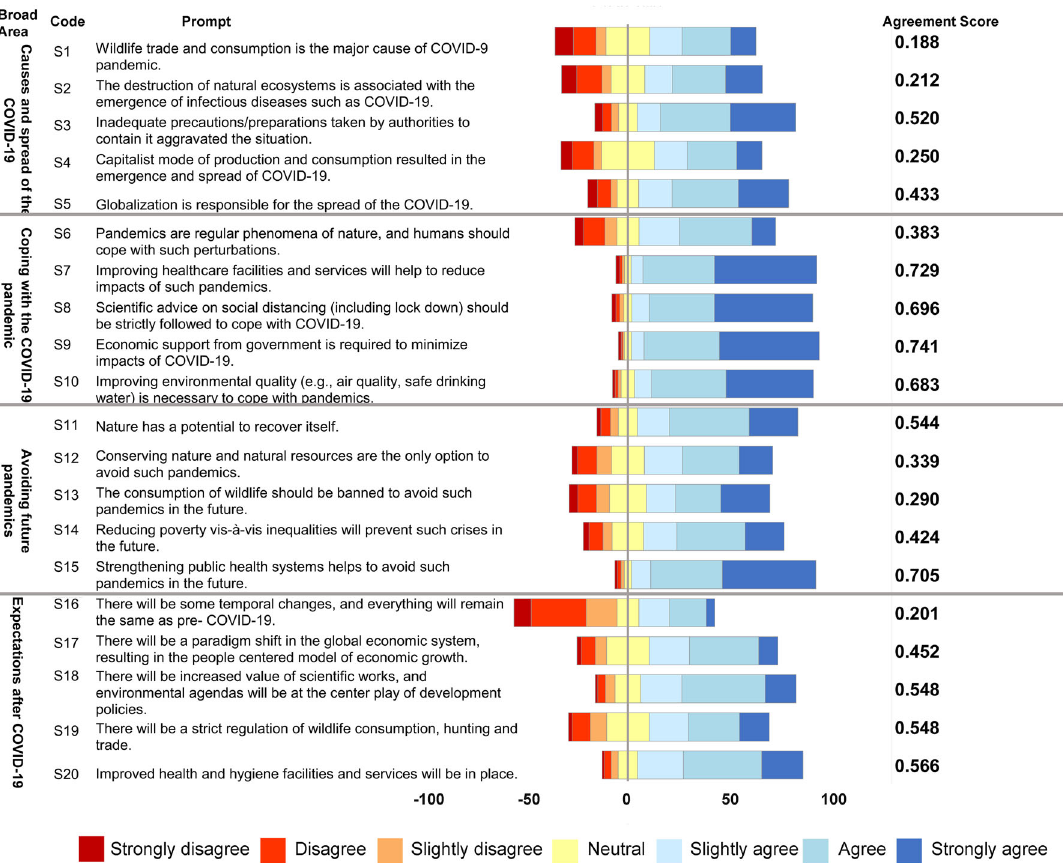
Fig. 3 The views of participants about (a) cause and spread of COVID-19, (b) coping with COVID-19 pandemic, (c) avoiding future pandemics, and (d) expectation after COVID-19 to the seven-point Likert score. The distribution of responses is shown for each survey item. The agreement score provided next to the bar diagram ranges from − 1 to − 1, where 1 denotes a complete agreement on a prompt; 0 denotes equal agreement on all categories, and − 1 denotes complete lack of agreement. The details of scores by economies of respondents ’ countries of citizenship are provided in Supplementary Table